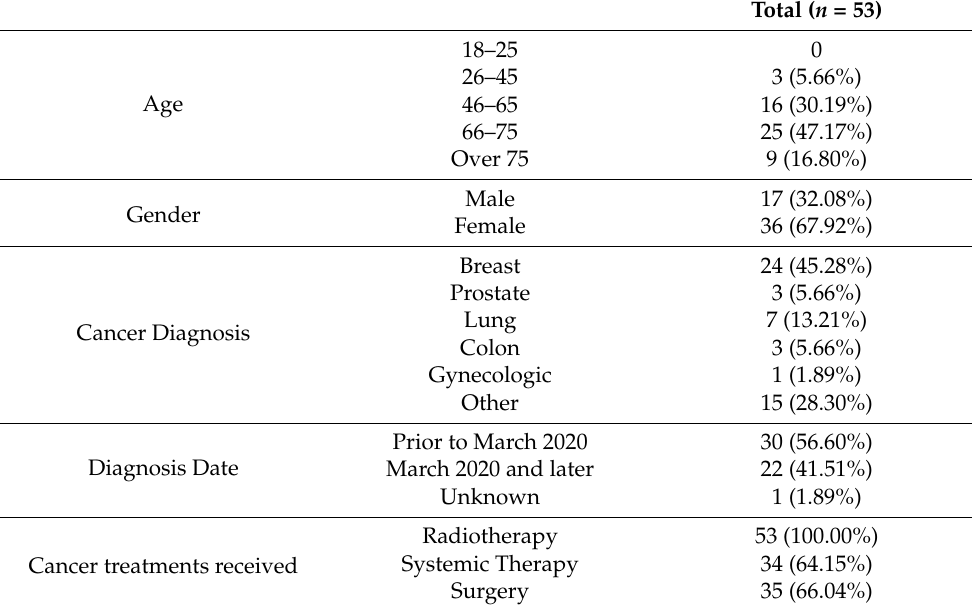
Table 1. Patient Demographic Data.